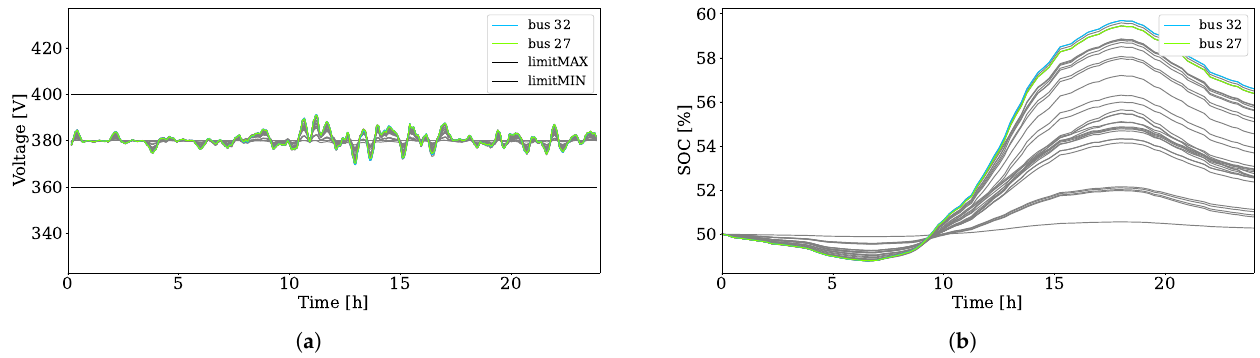
Figure 13. Results without the schedule. ( a ) Voltage with no schedule applied; ( b )